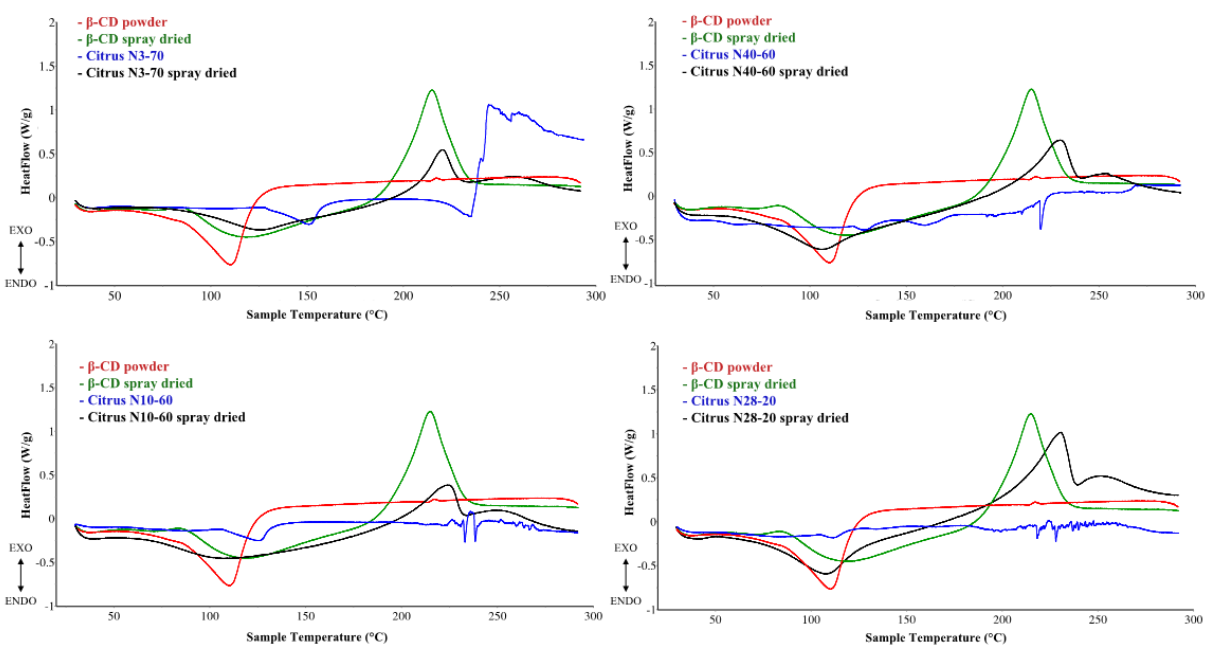
Figure 1. Comparison of thermal stability between commercial β -CD powder (red line), β -CD NaOH- solubilized and then sprayed (green line), started extracts (blue line) and encapsulated extracts (black